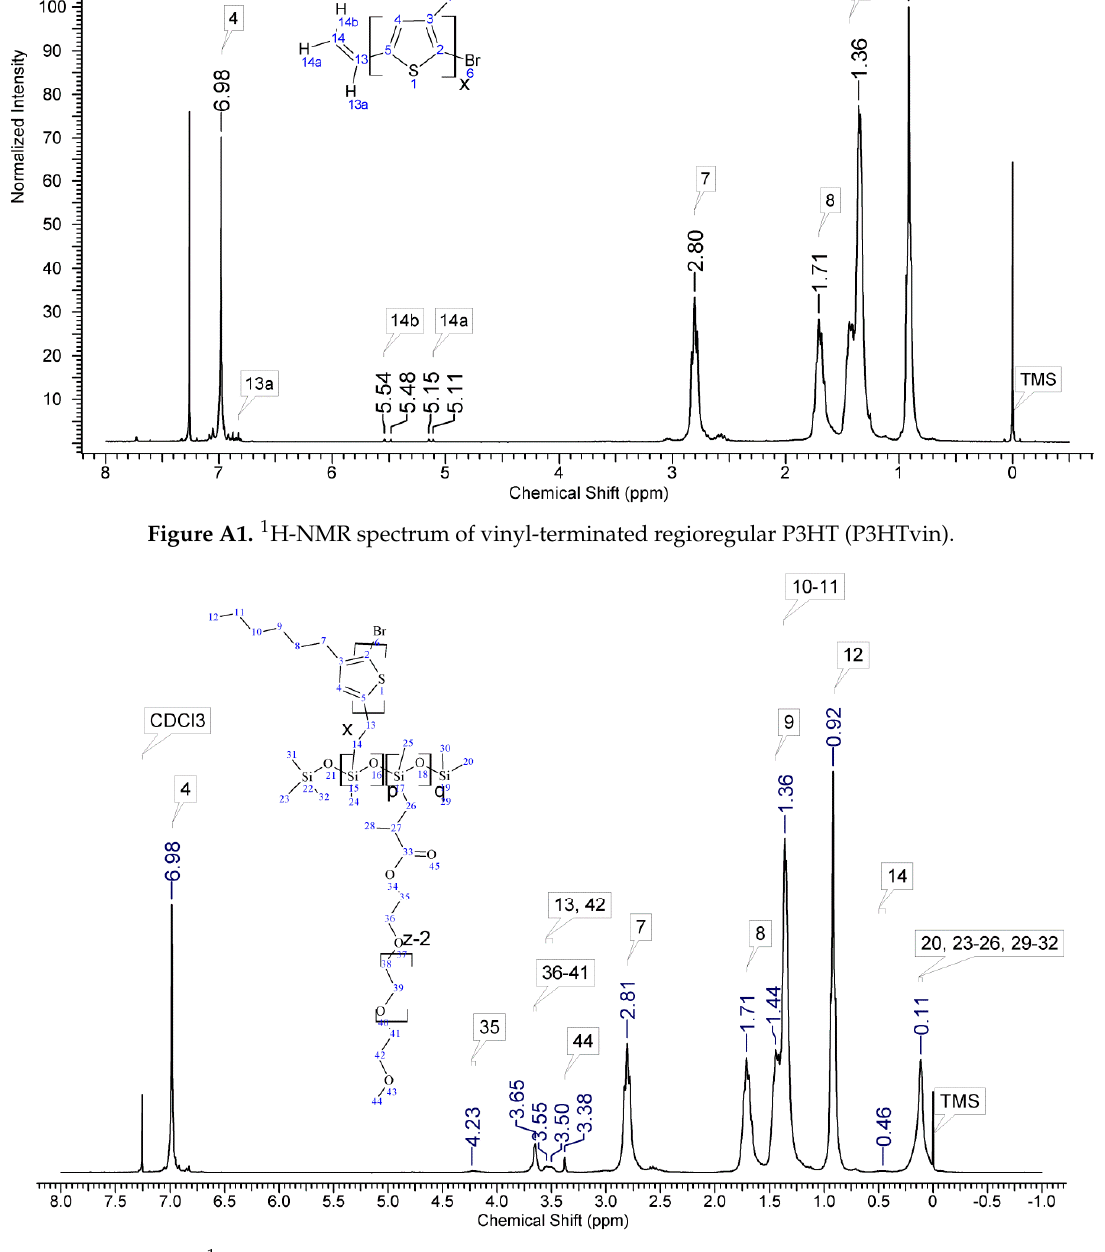
Figure A2. 1 H-NMR spectrum of poly(methylhydrosiloxane)-graft-[poly(3-hexylthiophene); poly(ethylene glycol) methyl ether methacrylate] (PEG M n ≈ 300) (SilPEG1.1).